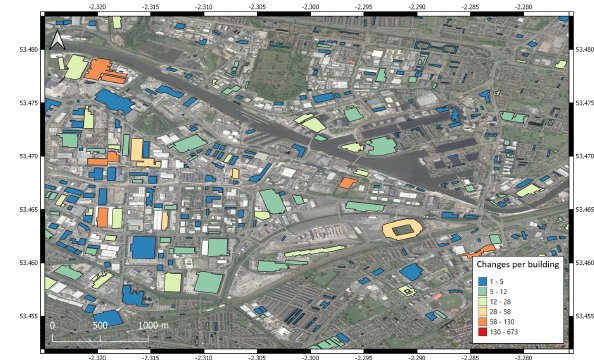
Figure 6: Classification of buildings according to the number of changes. Zoom of the results achieved by the joint SAR-GIS method over a limited area of Manchester (Map data: @2019 Google; Ordnance Survey data c (cid:13) Crown copyright and database right 2013).